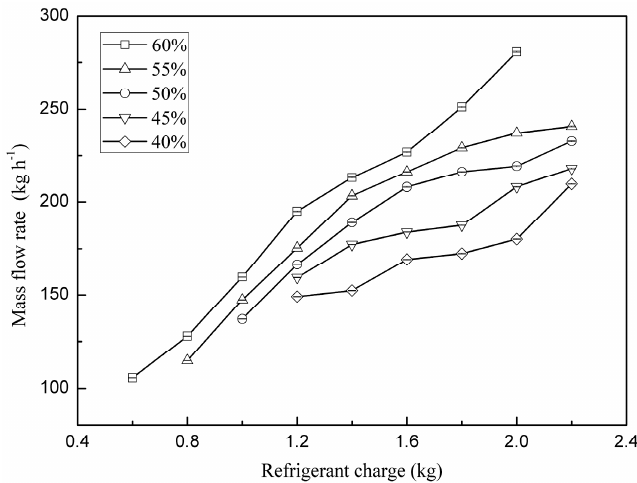
Figure 4. Variations of mass flow rate with refrigerant charge and EEV opening.